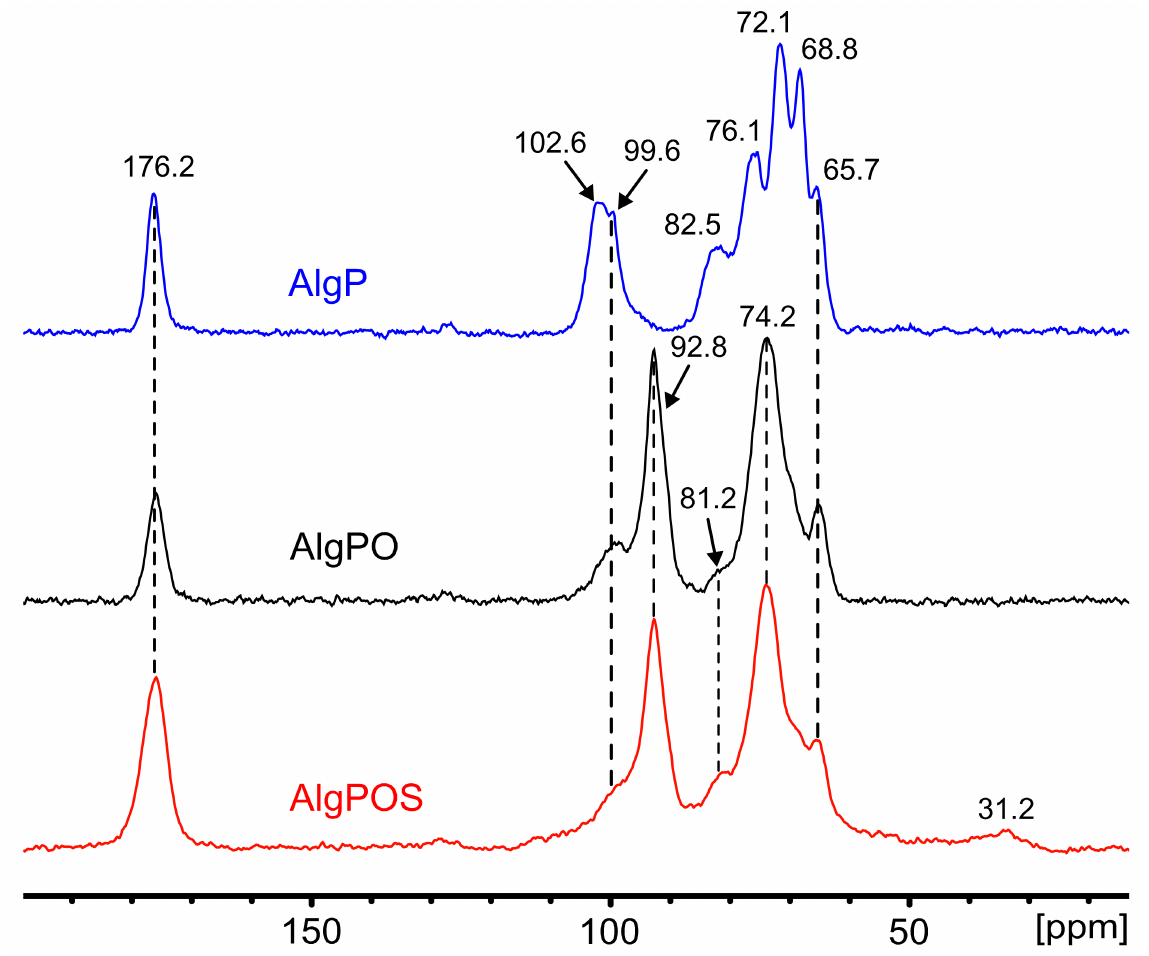
Figure 8. 13 C NMR in solid state in each step of functionalization. i. Starting material (AlgP), ii. Oxidized alginate (AlgPO) and iii. Alginate after reductive amination